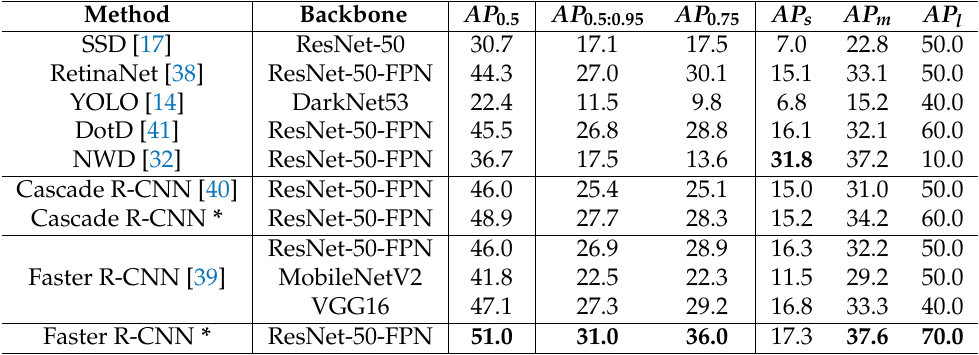
Table 4. Quantitative comparison of the baselines and the proposed method (with *) on Pest24 validation set.